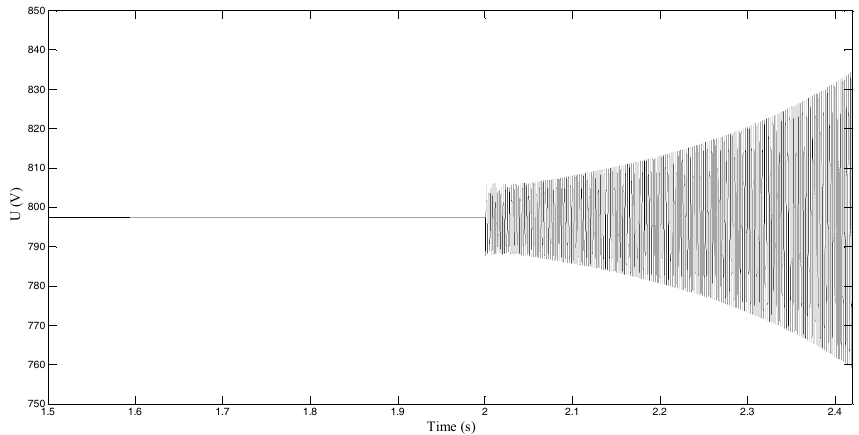
Figure 12. Simulation waveform of U dc when tripping slave VSC1 at t = 2 s without active stabilization control.